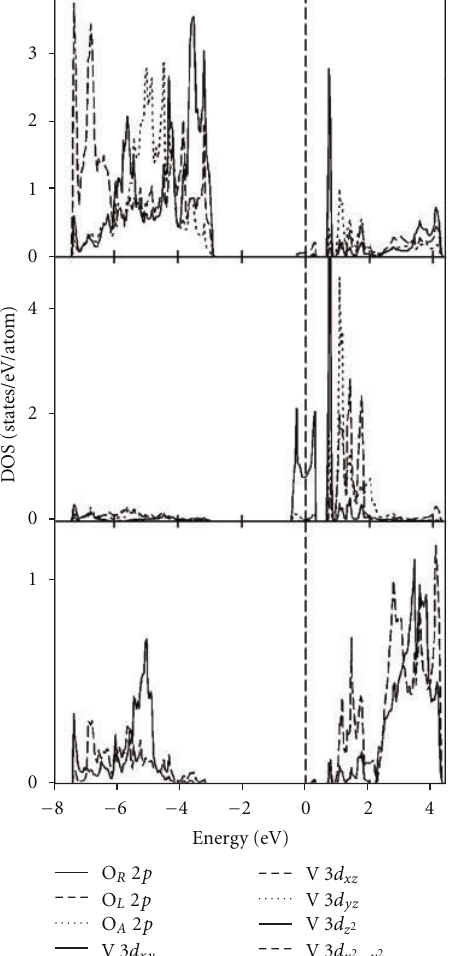
Figure 27: DOS curves calculated for V 3 d states of di ff erent sym- metry and for 2 p states of inequivalent oxygen sites in α (cid:2) -NaV 2 O 5 [245].